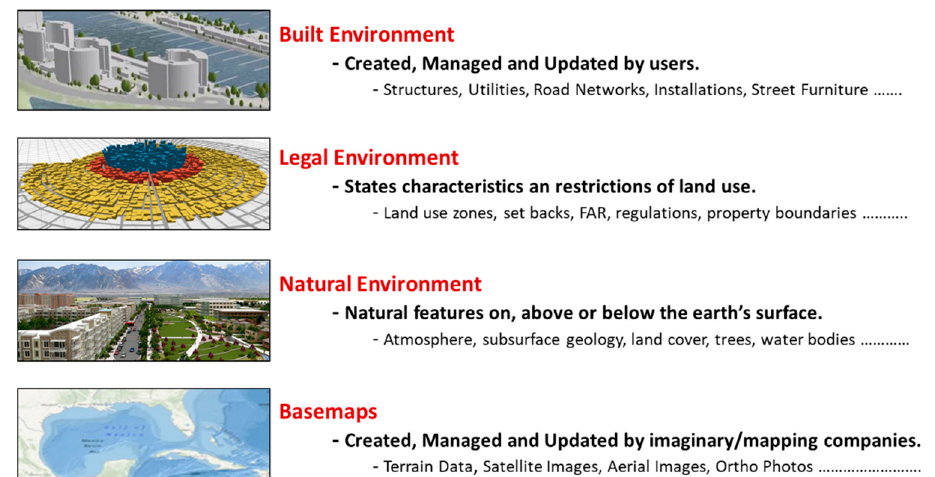
Figure 4. The 3D City Information Model (3DCIM) thematic structure by ESRI [33].